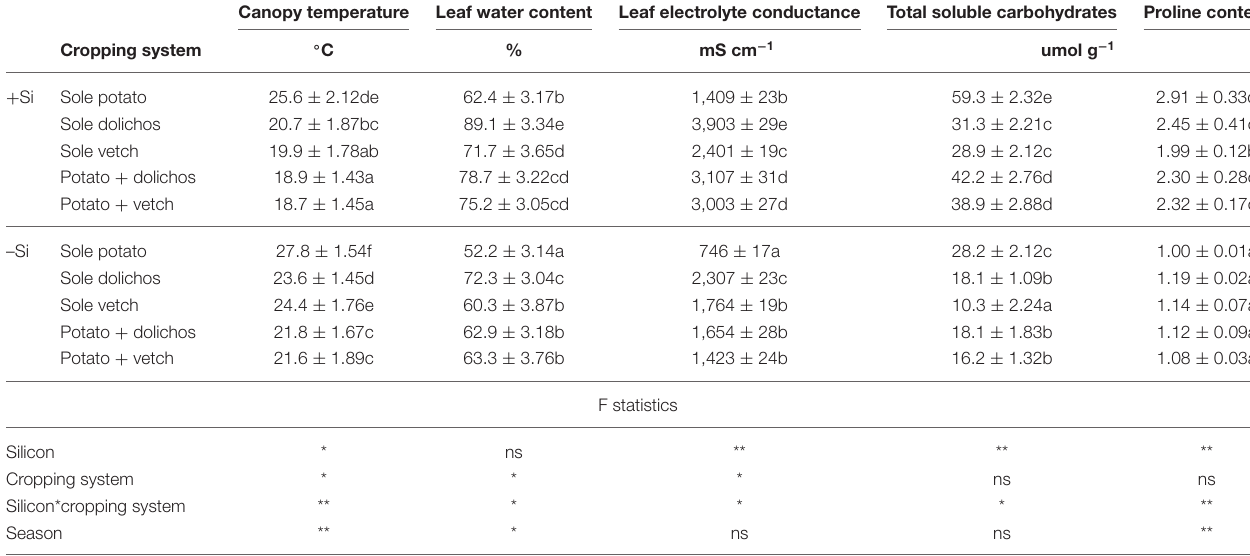
TABLE 4 | Silicon and intercropping effects on canopy temperature, leaf water content, and crop biochemical processes.